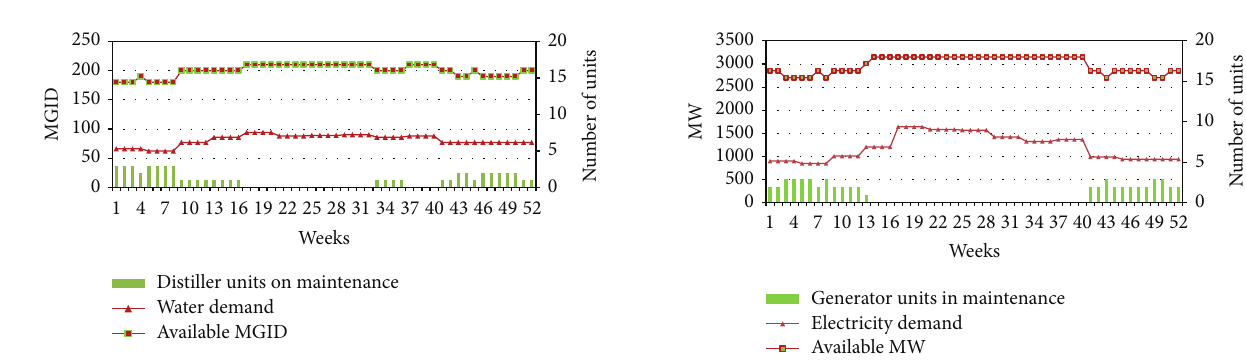
Figure 13: Distiller unit system output loads and gross reserves for 21 units.